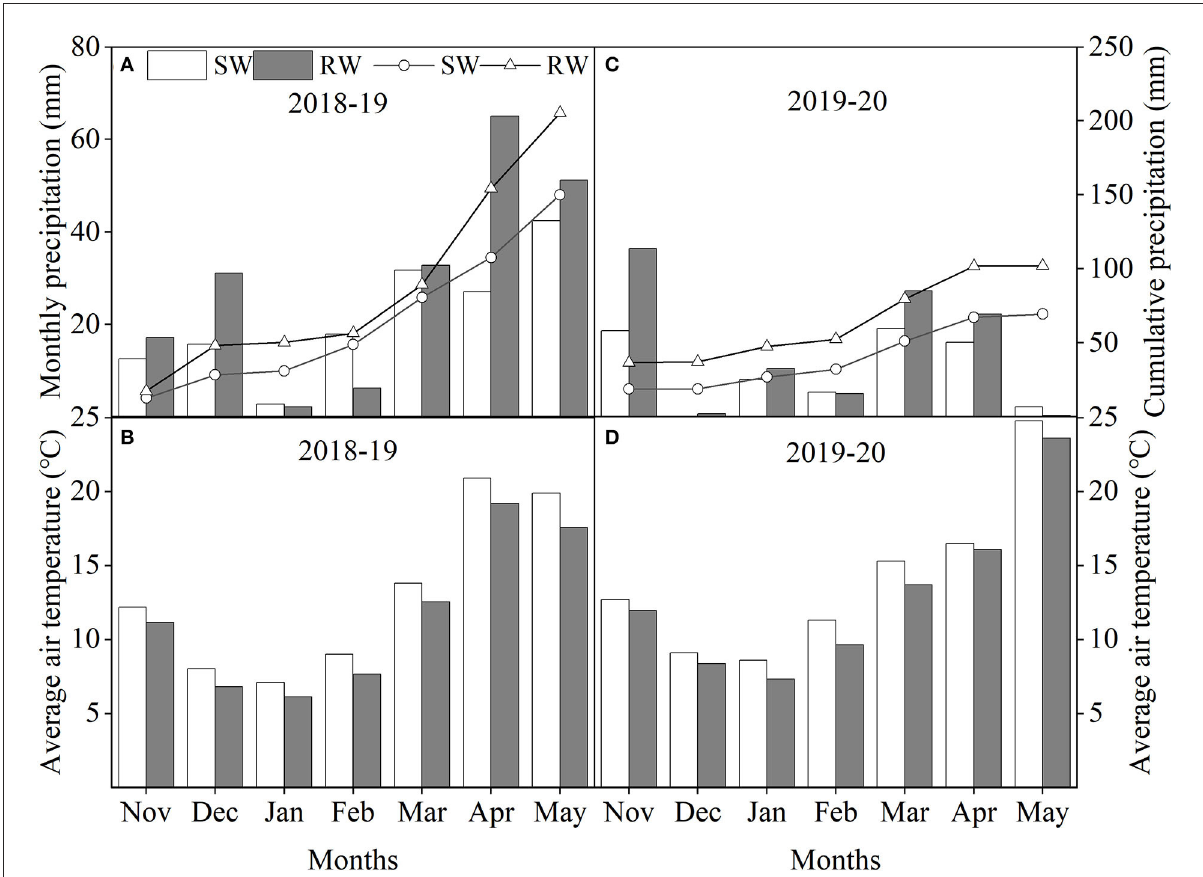
FIGURE1 Monthly precipitation, cumulative precipitation during 2018–19 (A) and 2019–20 (C) cropping years and average air temperature during 2018–19 (B) and 2019–20 (D) cropping years in two wheat cropping systems. All data were collected from sowing to physiological maturity in